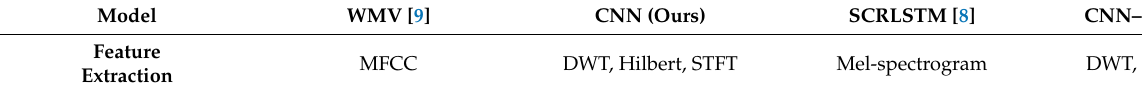
Table 6. Comparison between proposed and existing